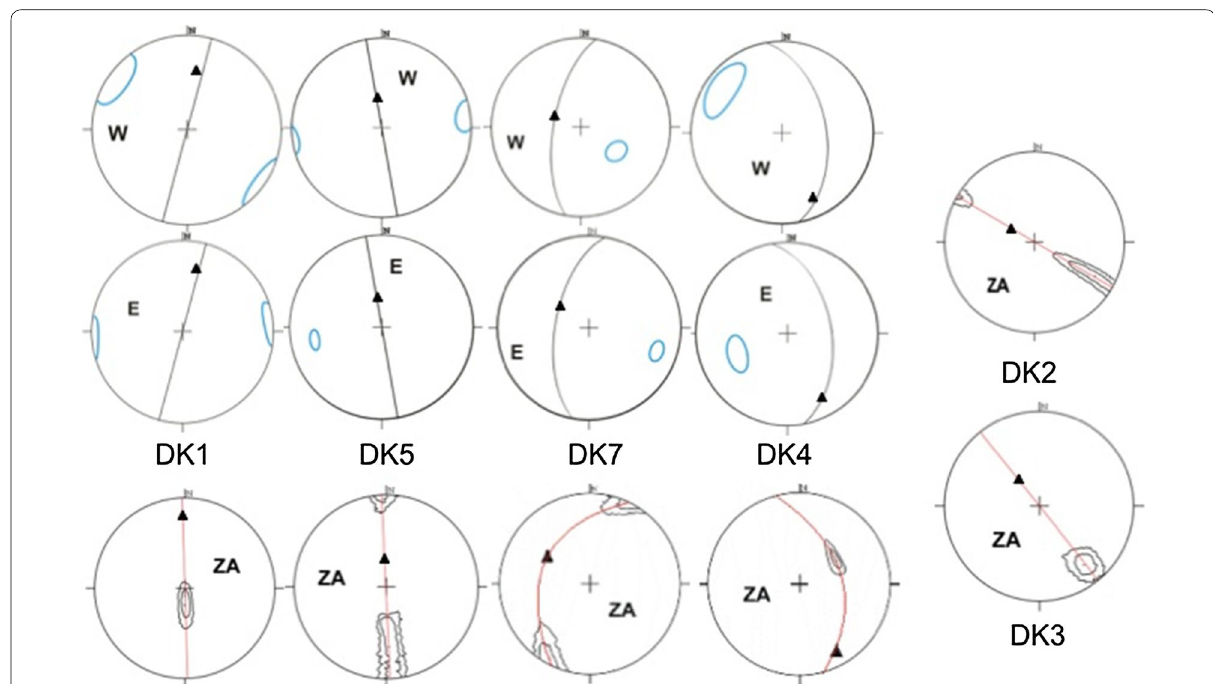
Fig. 11 Above: from dikes yielding reliable data (after rejection of abnormal fabric; see text), minimum confidence zone at 95% (Henry and Le Goff 1995). For K min axes(the great circle represents orientation of the dike plane, from field measurements). Below: magnetic zone axis (MZA), except for DK6 where it cannot be determined (too few normal fabrics), with its confidence zones at 95% and 63% (Henry 1997). Inferred flow direction is indicated by triangles (Schmidt diagrams, lower hemisphere). The orientation of the dike plane, suggested as materialized by the plane including the lengthening of the MZA confidence zone (red line), is slightly different from that obtained by the field measurement. The later is often only a rough estimate, particularly for the Hawaiian dikes, and the data from the MZA probably allow a more precise determination of this